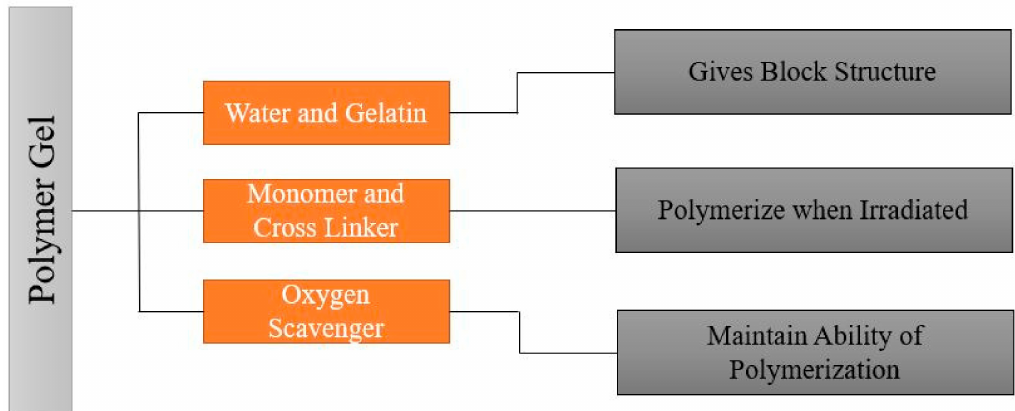
Figure 2. General composition of the polymer